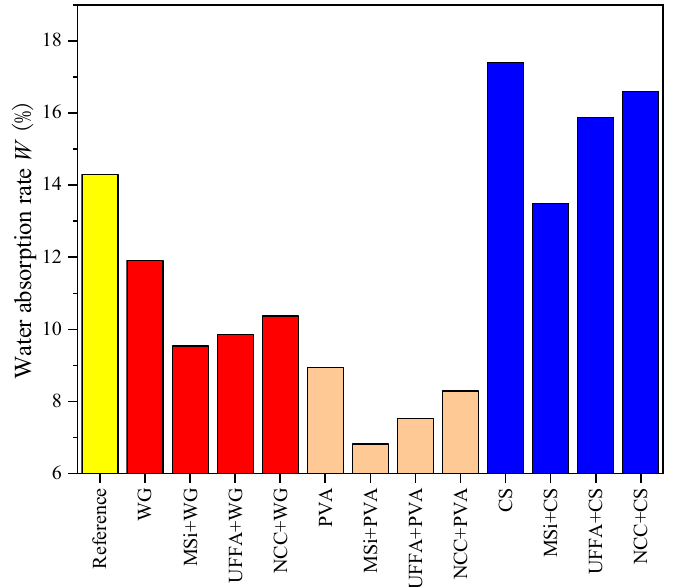
Figure 2. Water-absorption rate W for recycled aggregates with different strengthening methods.